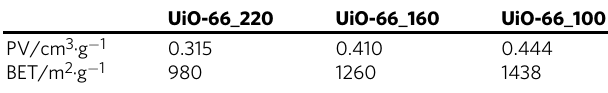
Table 2 Structural properties of the UiO-66 samples.